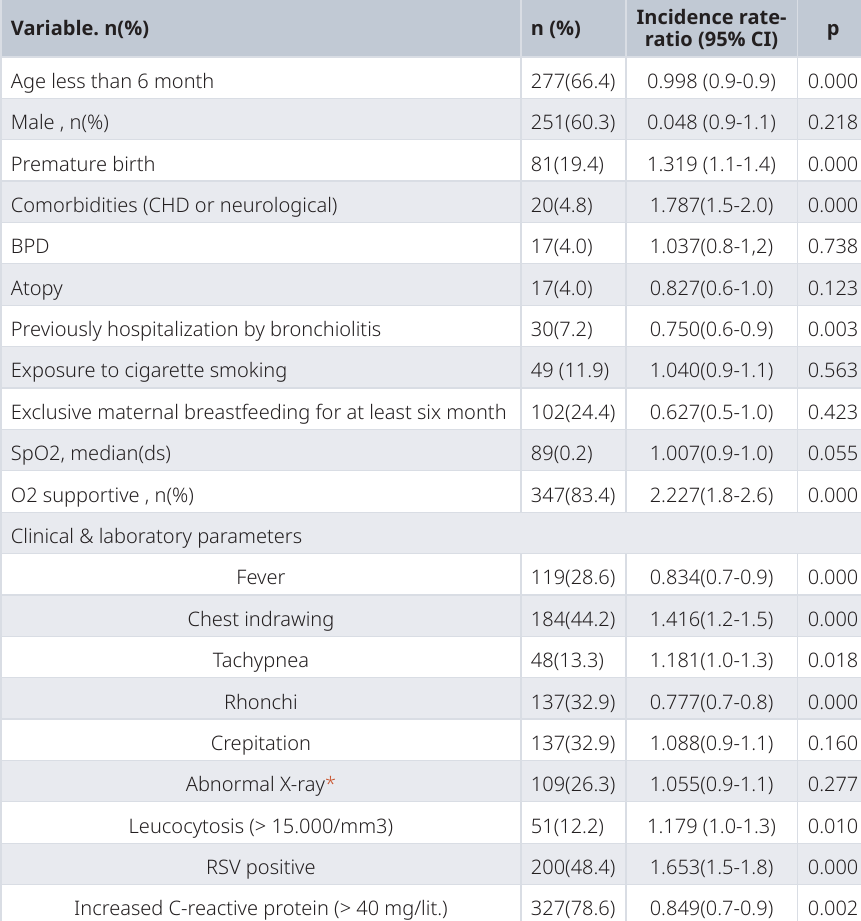
Table 2. Demographic features and clinical information of the patients included in the study.